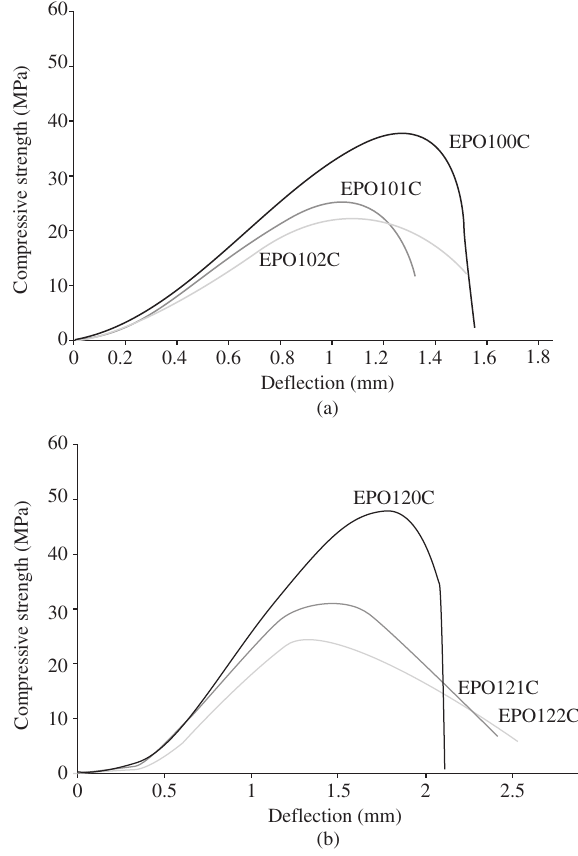
Figure 5. Some representative compressive strength vs. deflection curves of textile polymer concrete specimens.